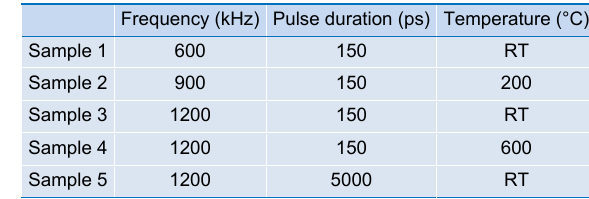
Table 3 | Manufacturing